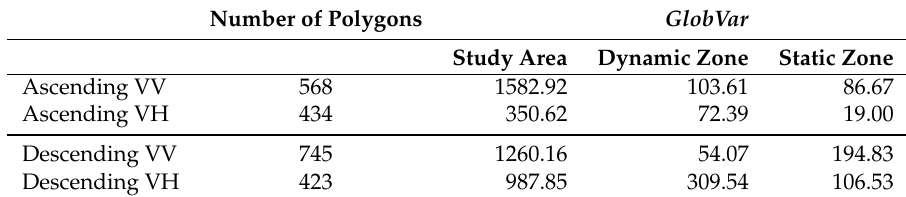
Table 2. Number of polygons in the SITS and global variation for the whole study area and regions of